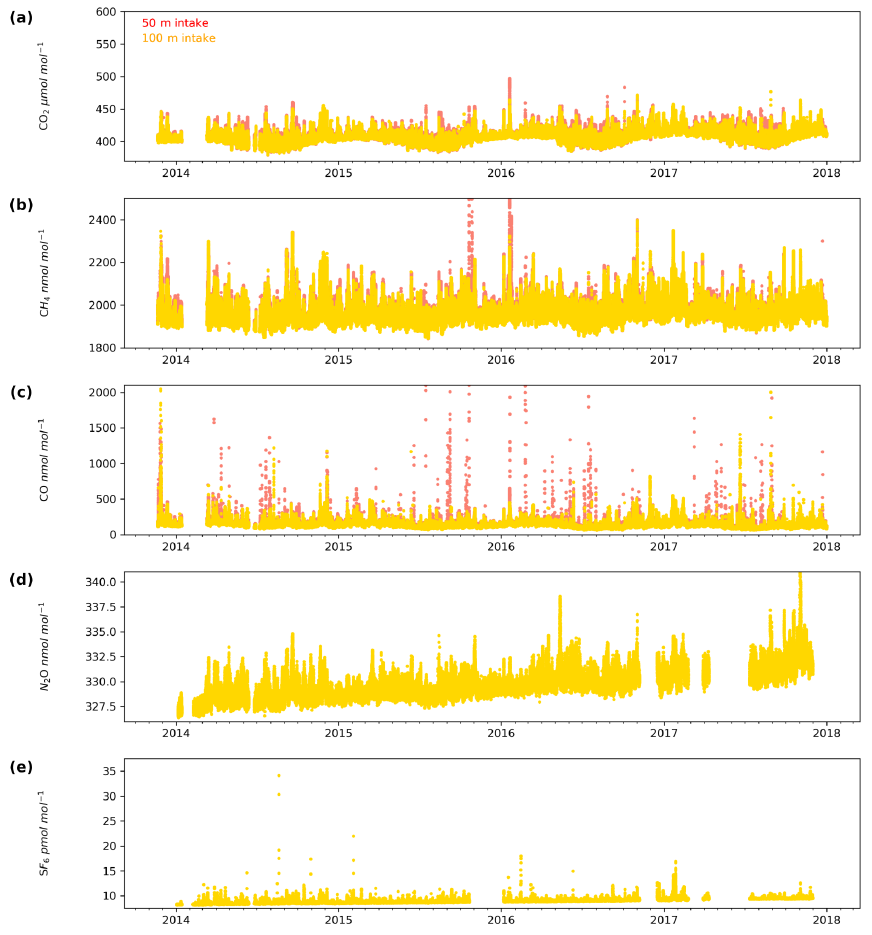
Figure 5. Minute-mean (a) CO 2 , (b) CH 4 and (e) CO and 10min discrete (d) N 2 O and (e) SF 6 observations at the Heathfield site for the 50m (red) and 100m (yellow) intake